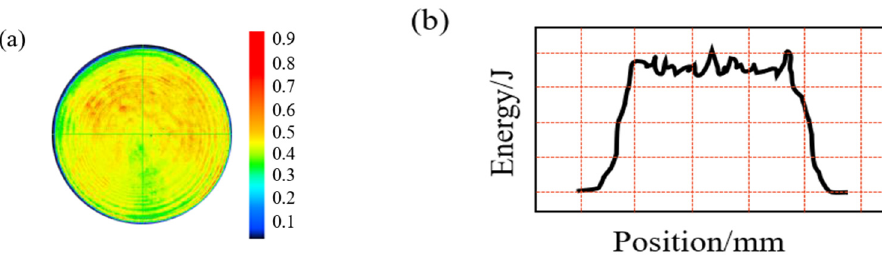
Figure 4. Spatial energy distribution of the flat-top laser beam. ( a ) Spatial energy distribution and ( b ) actual profile.